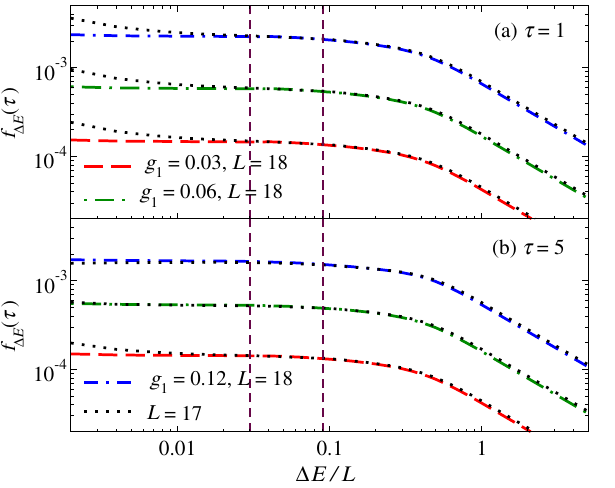
→ g 1 Þ [see Eq. (D2)] evaluated for quenches ˆ H FIG. 13. Γ Δ τ Þ , see Eq. (D1), evaluated for a wide range of E; τ ð I FIG. 12. f Δ E ð ˆ H 0 . 03 , 0.06, and 0.12. The results ˆ H → ˆ H 1 [see Eq. (36)] with g 1 ¼ energy windows Δ E for quenches 1 [see Eq. (36)] with I reported are from full exact diagonalization of chains with L ¼ τ Þ is computed using full exact g 1 ¼ 0 . 03 , 0.06, and 0.12. f Δ E ð 18 and periodic boundary conditions. The average thermalization diagonalization of chains with L ¼ 18 (see legends) and L ¼ 17 g 1 Þ over τ ¼ rate (horizontal line) is obtained by averaging Γ Δ E; τ ð (dotted lines) and periodic boundary conditions. The vertical lines 1 ; 1 . 5 ; … ; 5 (nine values) and over Δ E=L ¼ 0 . 03 ; 0 . 032 ; … ; 0 . 09 τ Þ is delimit the range Δ E=L ∈ ½ 0 . 03 ; 0 . 09 (cid:2) in which f Δ E ð g 1 Þ entering each (31 values), for a total of 279 values of Γ Δ approximately constant. E; τ ð average